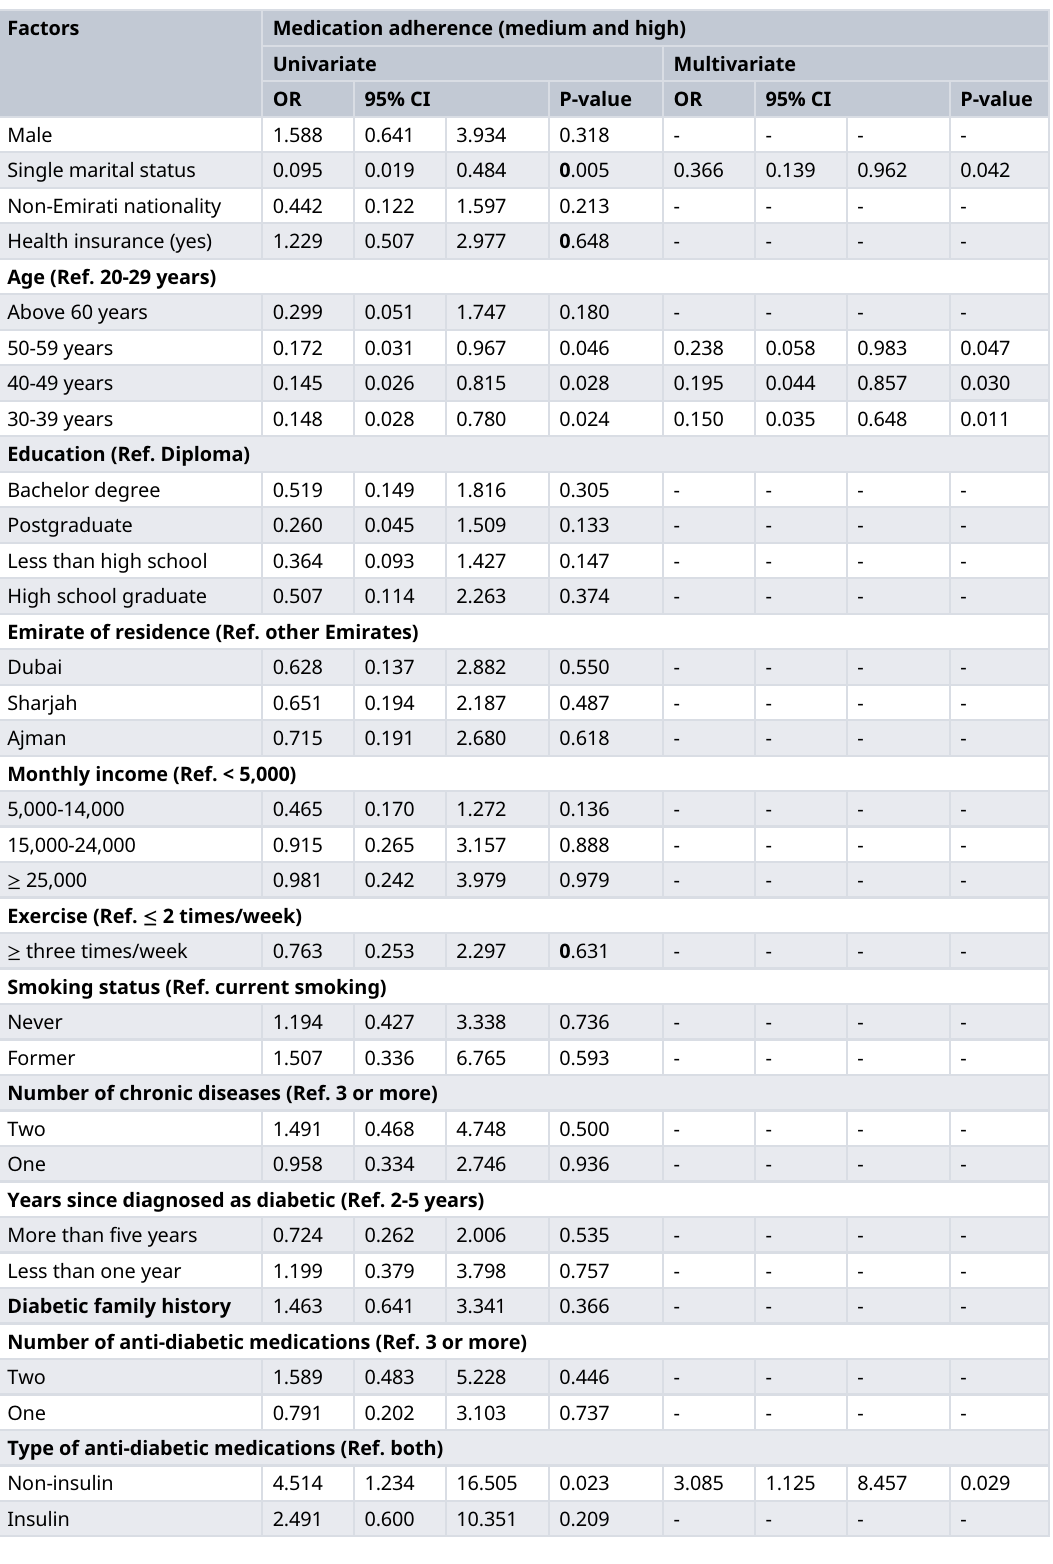
Table6.Univariateandmultivariateregressionanalysis forthefactorassociatedwithmedicationadherence among patients with type 2 diabetes mellitus with single marital